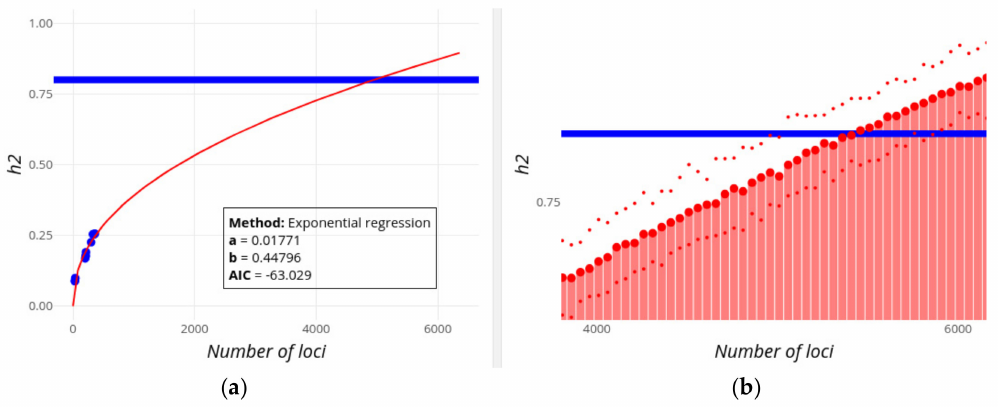
Figure 4. Screenshot of GWEHS (Genome-Wide E ff ect size and Heritability Screener) showing the inferences on the increase of heritability ( h 2 ) as new loci are found for human Height, using the default parameters (up to 6,000 loci). ( a ) Inferences using a regression method of the change in heritability with the number of loci. Blue points indicate observed values from di ff erent sets of PMIDs. The red line corresponds to the regression fit. A text box includes the distribution parameters and the Akaike information criterion (AIC) value. ( b ) Inferences using a regression method on the parameters of the distribution of e ff ect sizes and minor allele frequencies (MAF), and sampling heritability values. The blue line indicates the assumed familial heritability. The red bars correspond to the heritability sampled. The red points show the median (large point), and 0.975 and 0.025 quantiles of that heritability (upper and lower small points, respectively). Note that this image has been zoomed, which is one of the interactive utilities supported by the R Shiny package.